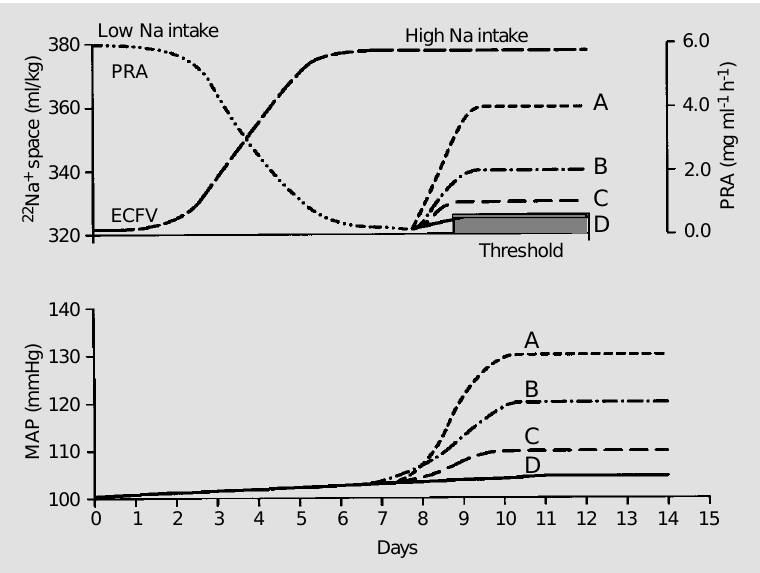
Figure 2 - Reciprocal changes in plasma renin activity (PRA) and extracellular fluid volume (ECFV) that occur when a low sodium diet is shifted to a high sodium diet (upper figure). This change contributes to the maintenance of mean arterial pressure (MAP) (lower figure). Infusion of different doses of ang II (A, B, and C) which maintain the plasma levels of this peptide inappropriately high with respect to ECFV produces hypertension. D , Smaller doses of ang II than (C) do not appear to alter